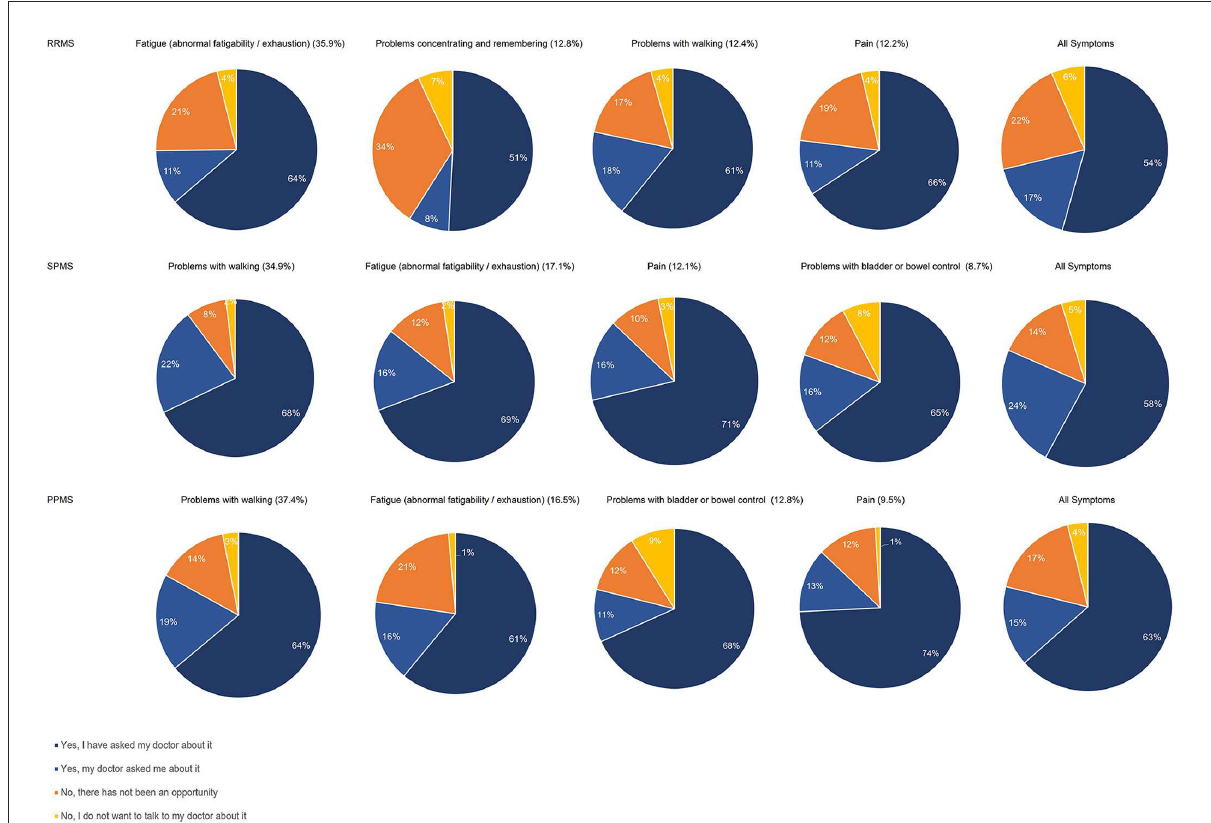
FIGURE5 Reporting of most disabling symptoms worsened in the last 12 months independent of relapses by subtype; % in brackets gives the proportion of patients who reported the symptom in the respective subpopulation.